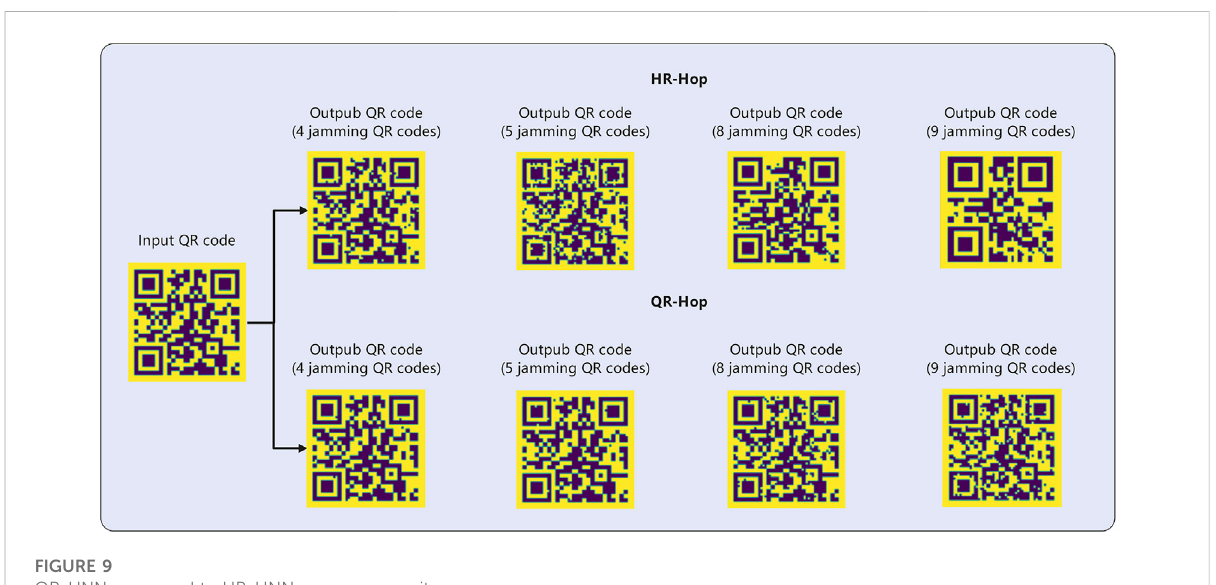
FIGURE 9 QP-HNN compared to HR-HNN memory